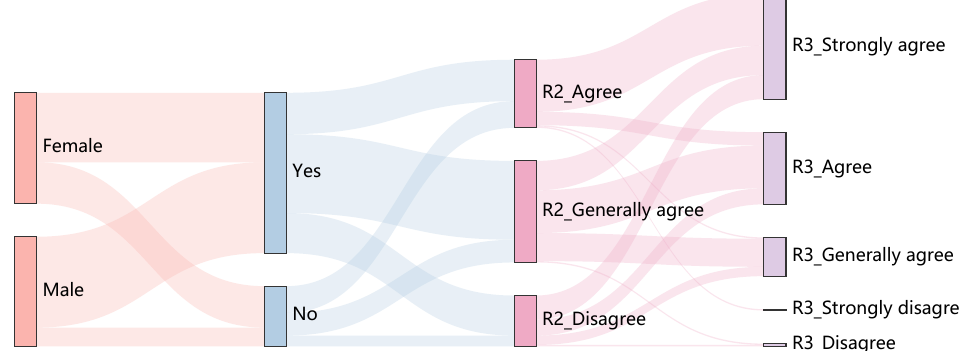
Figure 15. Sankey Diagram results for Gradient-weighted Class Activation Mapping (Grad-cam). The third column shows the distribution of top-3% of user satisfaction, and the fourth column shows the distribution of top-8% of user satisfaction. Grad-cam method is tested with 10 images from DataS and 35